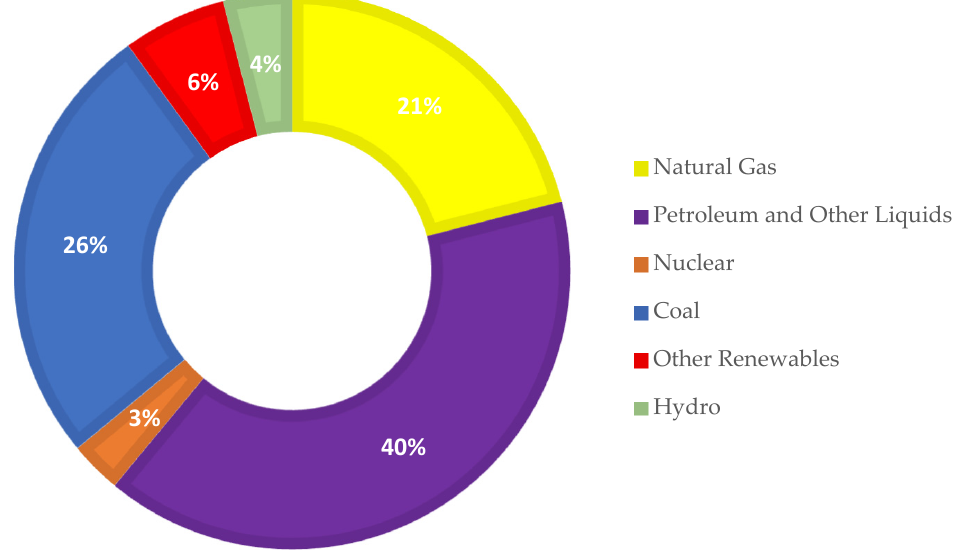
Figure 1. Japan Total Energy Consumption in 2019 Source: BP [17]. In 2018, the majority of oil in Japan was consumed in the industrial (24%), non-energy consumption (16%), and transportation (38%) sectors. The power sector’s share has fallen from a peak of 19% in 2012 to 5% in 2018, when the sector started to substitute oil